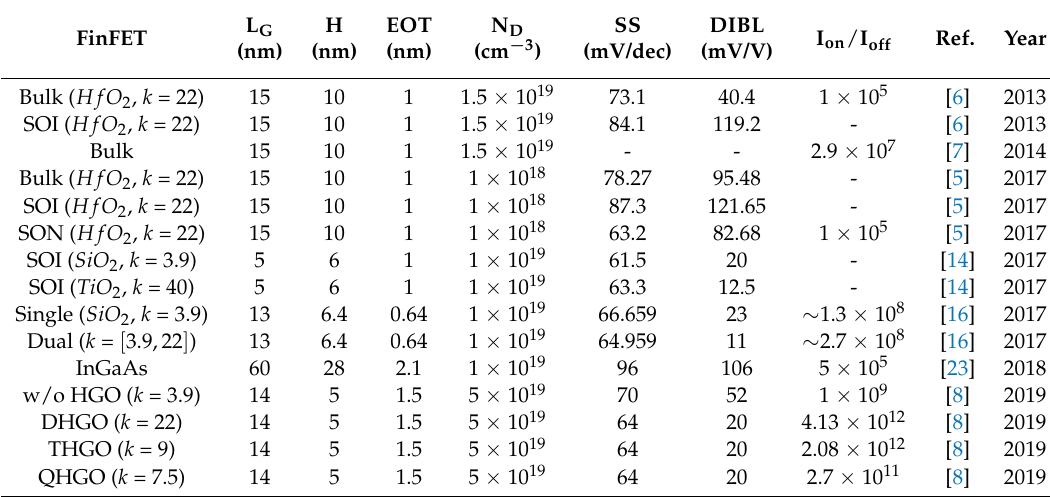
Table 2. Reported figure of merits of junctionless FinFETs. EOT is the equivalent gate oxide thickness, while k is the gate oxide dielectric constant.